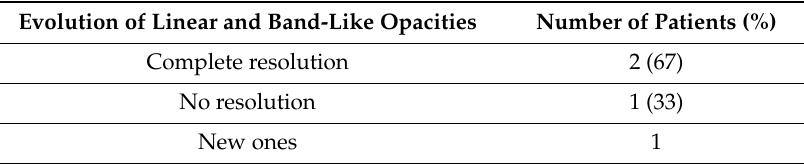
Table 10. Evolution of the 3 patients with linear and band-like